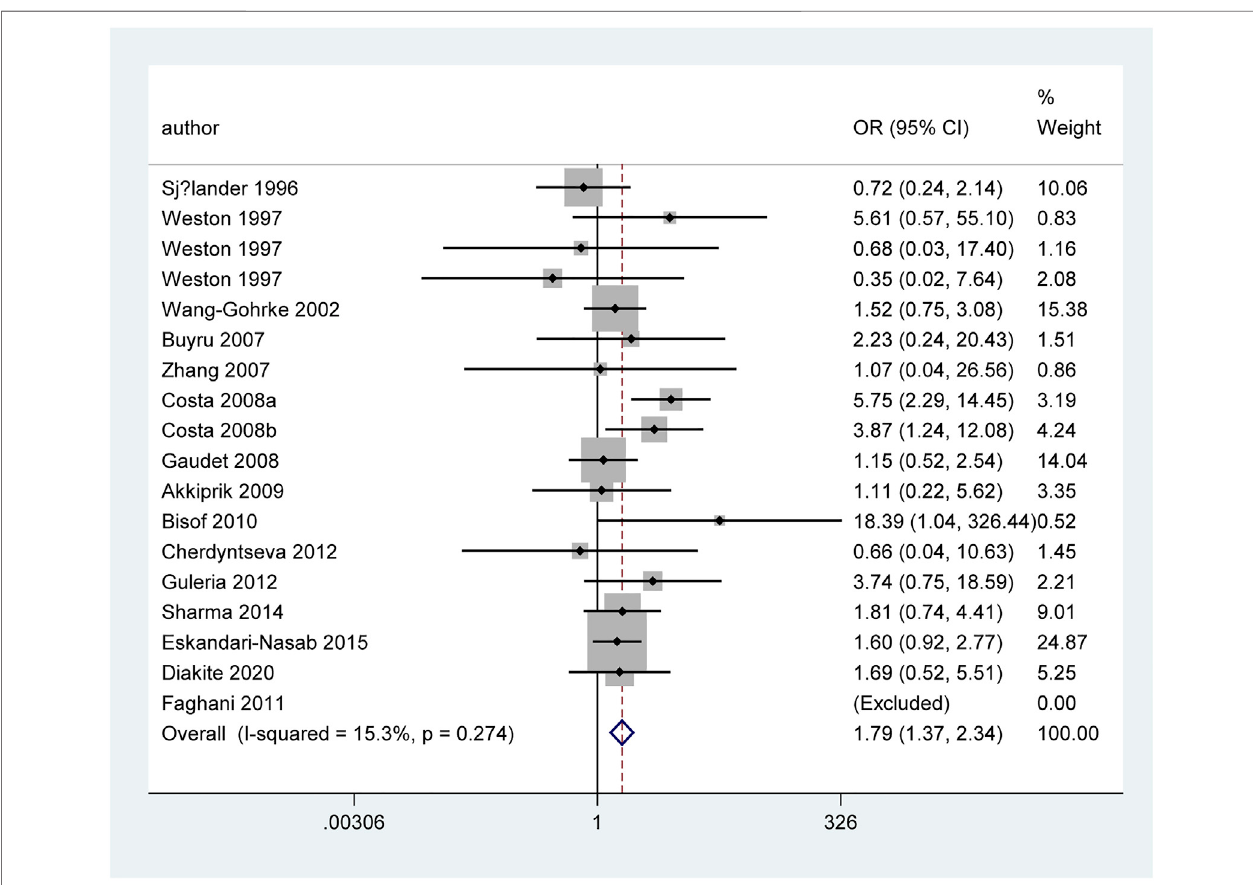
FIGURE 4 | Forest plot of the association between TP53 IVS3 16 bp polymorphism and BC risk in matched subgroup analysis (GG vs. CC + CG).